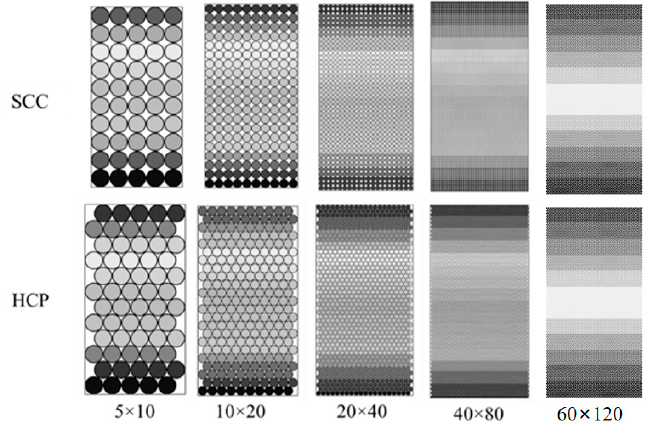
Figure 5. Stiffness Validation Models of SCC and HCP Ball Figure 5. Sti ff ness Validation Models of SCC and HCP Ball Arrays.